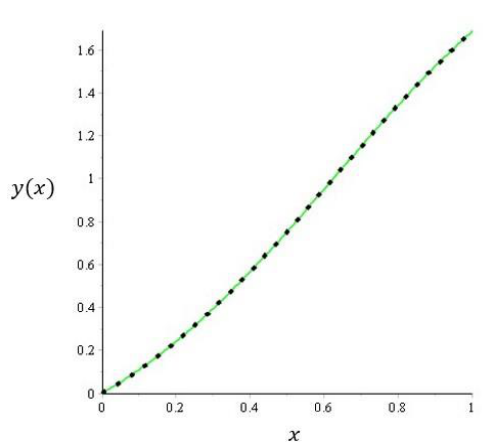
Figure 1. Graphics of RFDE solution using the ADM-Kamal Combined Theorem (26) for α = 0.7, α = 0.8, α = 0.9, and α = 1.